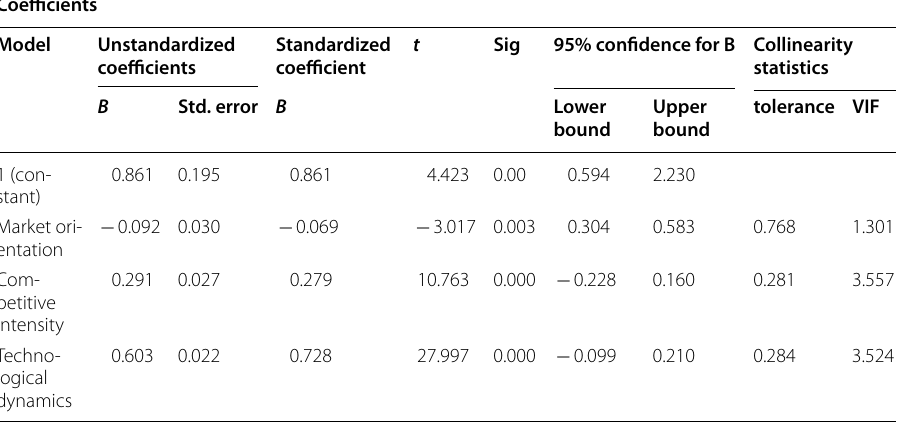
Table 6 Standardized coefficient